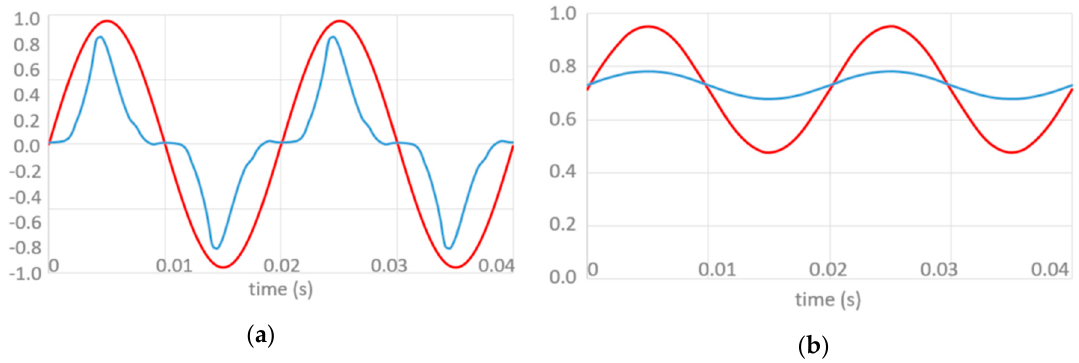
Figure 4. Switching-mode single-stage driver: depending on the position of the capacitor Cs , the single dc-dc converter can provide both PFC and output current regulation.